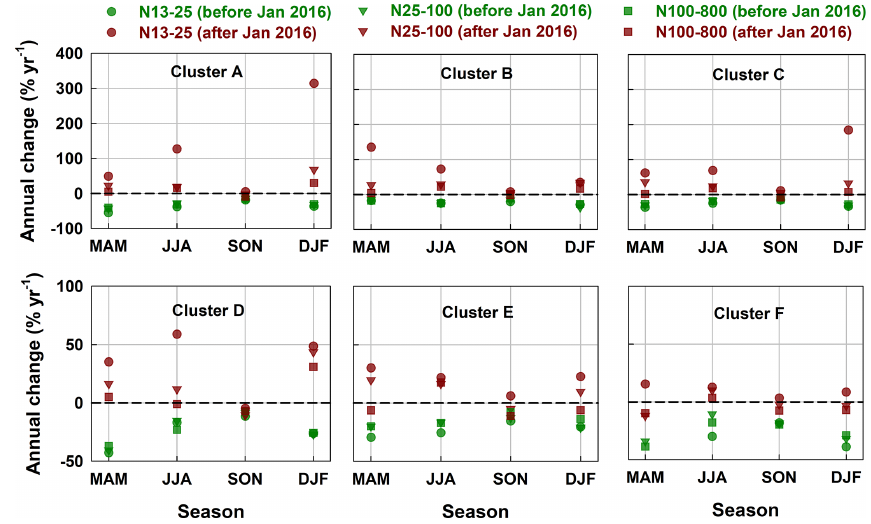
Figure 9. Seasonal variations in the trends of PNCs in three modes for the two contrasting periods (before vs. after January 2016) for each cluster. The annual change is calculated by Theil–Sen regression, and the calculation is shown in Sect. 2.4 (Trend analysis methods). MAM, JJA, SON and DJF refer to spring, summer, fall and winter,